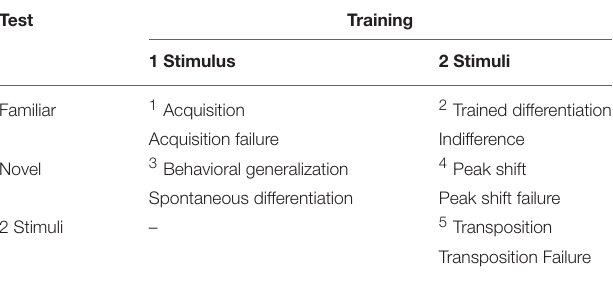
TABLE 2 | Learning performance outcomes.